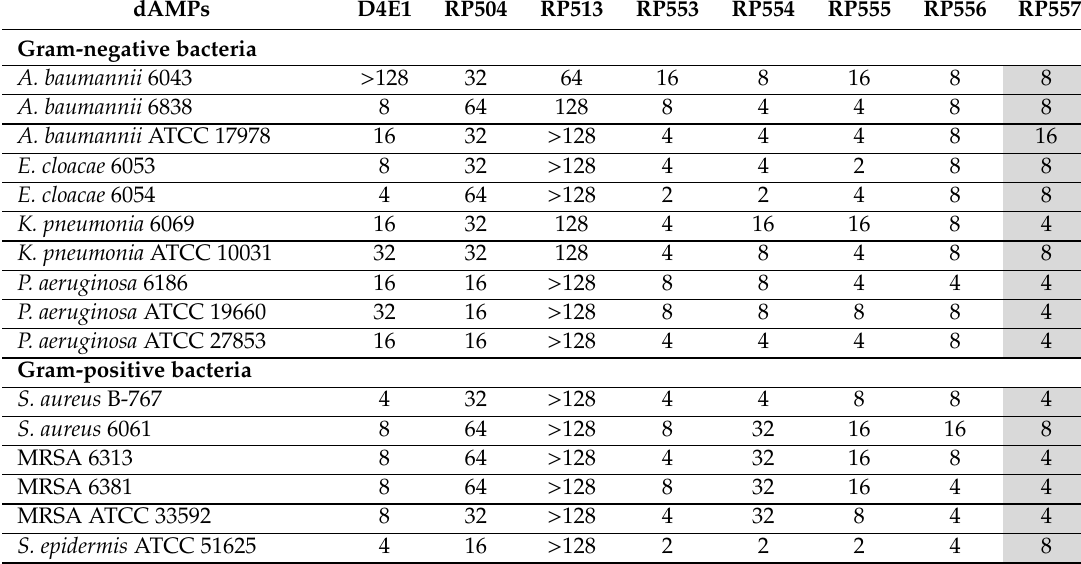
Table 2. MICs ( µ g / mL) against Gram-positive & Gram-negative